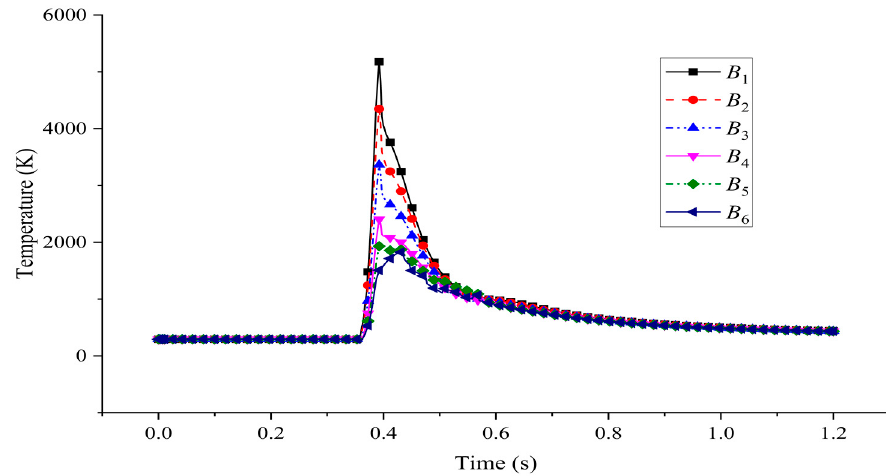
Figure 8. The thermal history of the sampling points on the AISI 304L side.